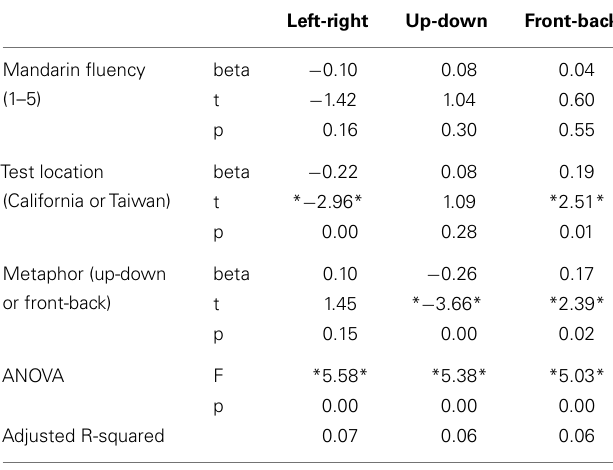
Table 5 | Results of linear regression analyses for each of the three axes (left-right, up-down, front-back) with the three factors as predictors: (1) Proficiency in Mandarin (2)Test location, and (3) Metaphor in Study